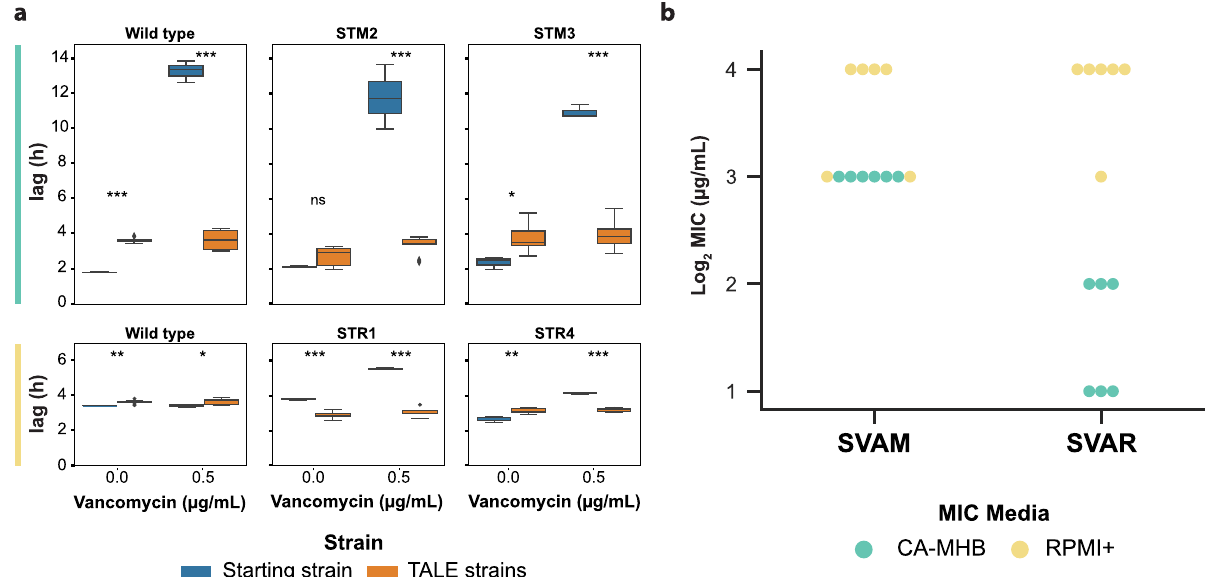
Fig. 2 Phenotypic changes observed in vancomycin-tolerized strains. a Box plots displaying growth tradeoffs grouped by the starting strain for each set of TALE experiments. Evolution starting strains and vancomycin adapted strains were grown in the absence and presence of vancomycin. Assessment of the lag-phase duration of starting strains and evolved strains in the same media as that used for tolerization, CA-MHB (top, green) and RPMI + (bottom, yellow). Error bars represent one standard deviation. Evolved strain averages used 2, 3, or 4 distinct clones derived from the given starting strain (Supplementary Table 1), all determinations were made in triplicate. Values that are signi fi cantly different by ANOVA are indicated by asterisks (ns, non- signi fi cant; * P ≤ 0.05; ** P ≤ 0.01; and *** P ≤ 0.001) (Supplementary Table 3). An example of one of these growth curves, comparing pre-evolved and vancomycin adapted strain is presented in Supplementary Fig. 2. b A plot of Log 2 vancomycin MIC values of evolved strains from all TALE conditions tested in both media types. SVAR strain tolerance phenotypes in RPMI + were not maintained when tested in CA-MHB media. SVAM: S. aureus tolerized